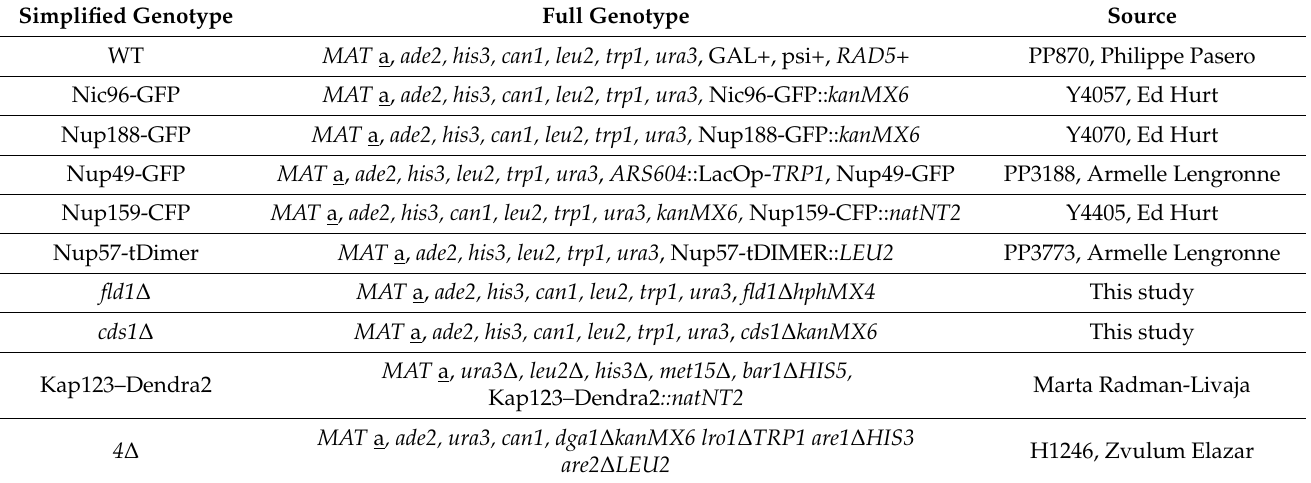
Table 1. Strains used in this study.